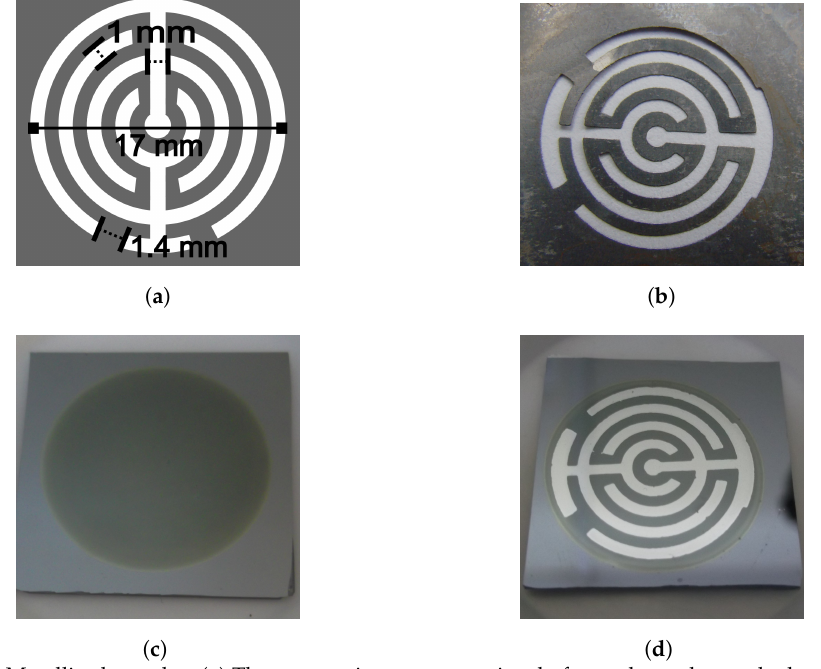
Figure 1. Metallic electrodes. ( a ) The geometric pattern consisted of two electrodes, each electrode was formed with two concentric no-closed rings of 1 mm width, a line of the same width connected them. ( b ) A photograph of the mask used to deposit the electrodes, made by lithography. ( c ) A photograph of the top view of a porous silicon sample; the area of the circle is porous silicon. The bulk silicon around and under the porous silicon serves as the substrate. ( d ) A photograph of a porous sensor with aluminium electrodes deposited on the porous area. The diameter of the outer no-closed ring was 17